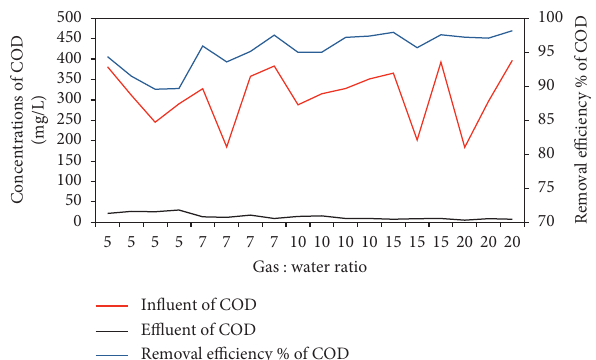
Figure 3: Performance of A/O MBBRs system for COD removal under different gas: water ratios.